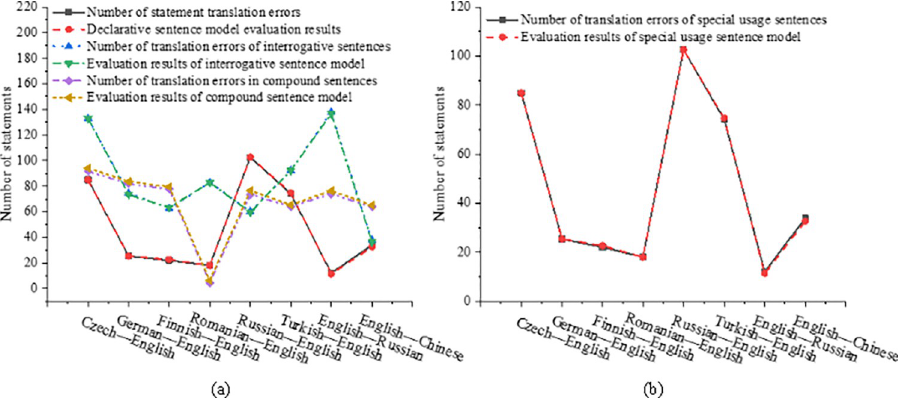
Fig 8. Translation quality. a: declarative sentences, interrogative sentences, and compound sentences; b: special usage